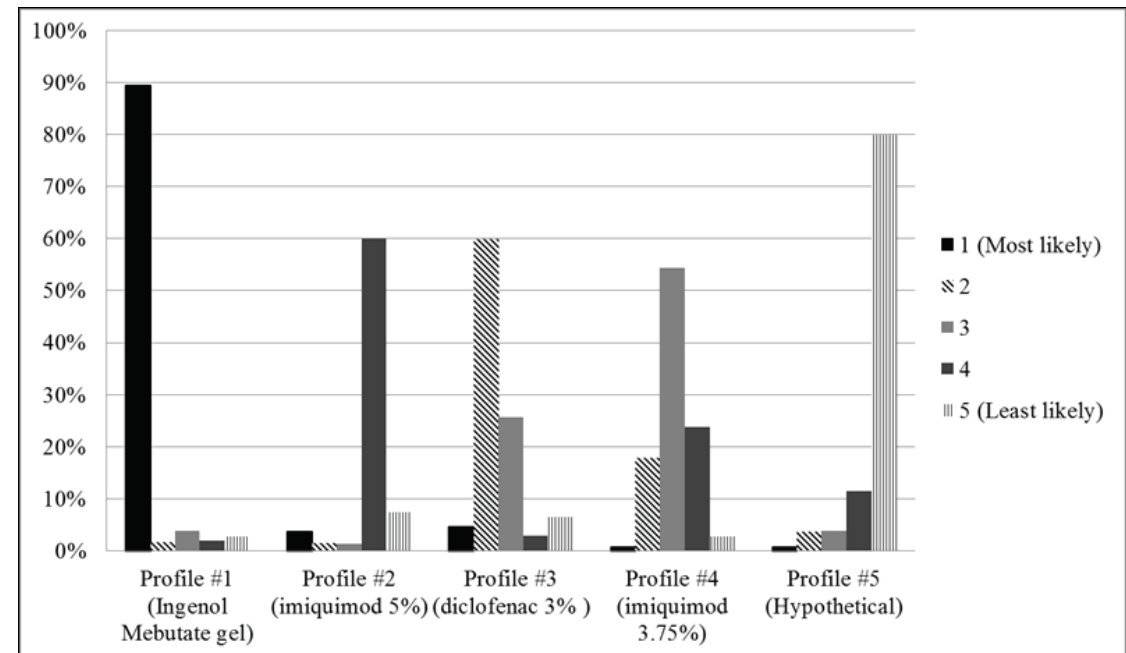
Figure 2. Ranking of Likelihood of Completing